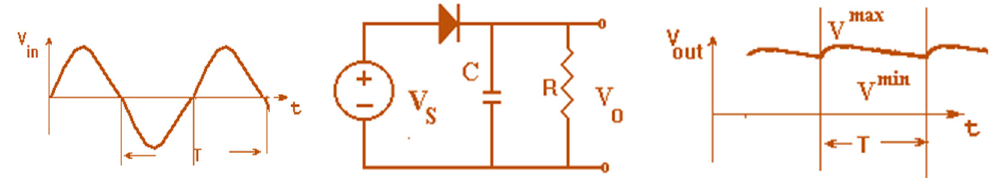
Figure 29. Voltage rectifier, half wave, with a shunt capacitor.